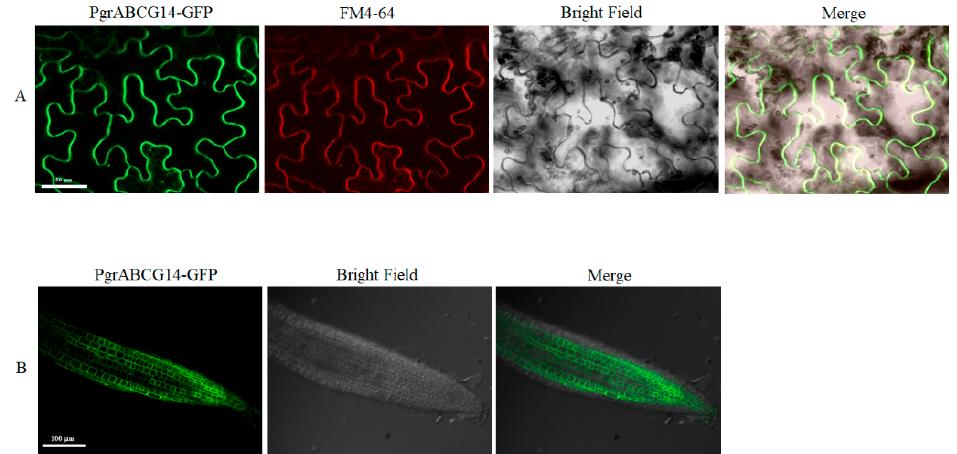
Figure 5. Subcellular localization of PgrABCG14-GFP fusion protein . ( A ) Subcellular localization of PgrABCG14-GFP in tobacco epidermal cells . Scale bar, 50 μ m. ( B ) Subcellular localization of PgrABCG14-GFP in transgenic Arabidopsis plants. Scale bar, 100 μ m.